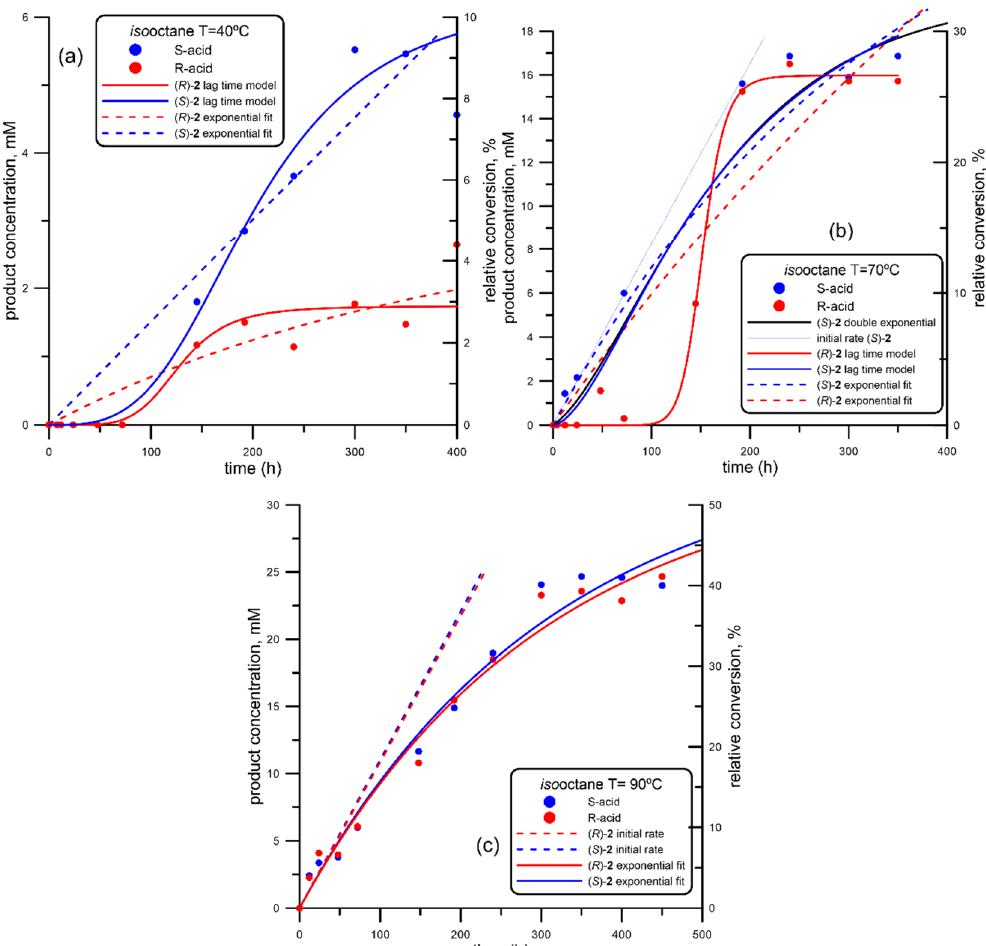
Figure 1. Progress curve of the lipase-form Geobacillus thermocatenulatus (BTL2)-catalyzed production of both enantiomers of mandelic acid (( R )-acid, in red; ( S )-acid, in blue) via ethanolysis of racemic 2-(butyryloxy)-2-phenylacetic acid ( R , S )- 1 , using isooctane as organic solvent at different temperatures. ( a ) 40 °C; ( b ) 70 °C; ( c ) 90 °C.